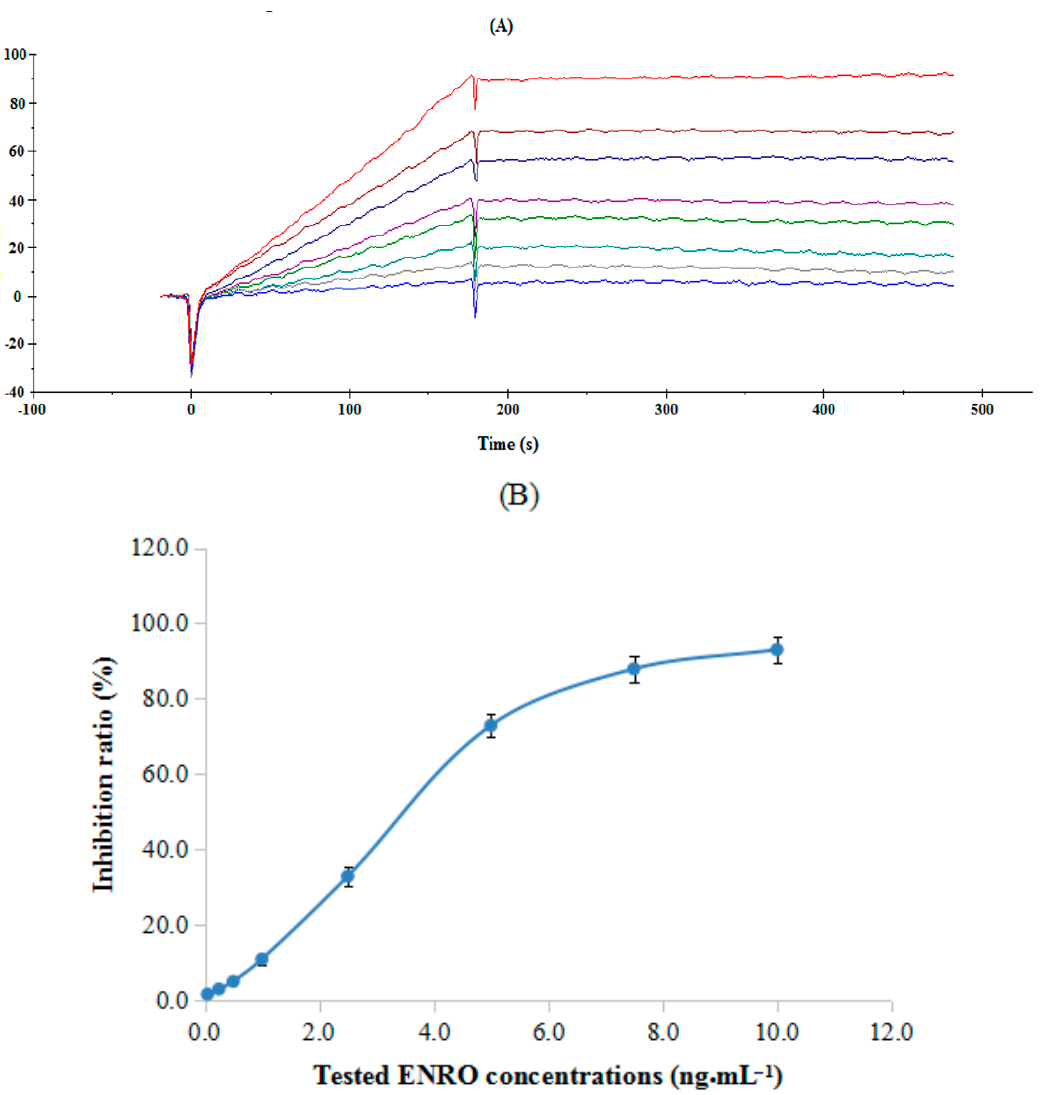
Figure 7. ( A ) SPR response from ENRO working solutions at different concentrations; ( B ) Inhibition Figure 7. (A) SPR response from ENRO working solutions at different concentrations. (B) Inhibition curve of ENRO in PBS (pH 7.4) using the developed SPR curve of ENRO in PBS (pH 7.4) using the developed SPR immunosensor.